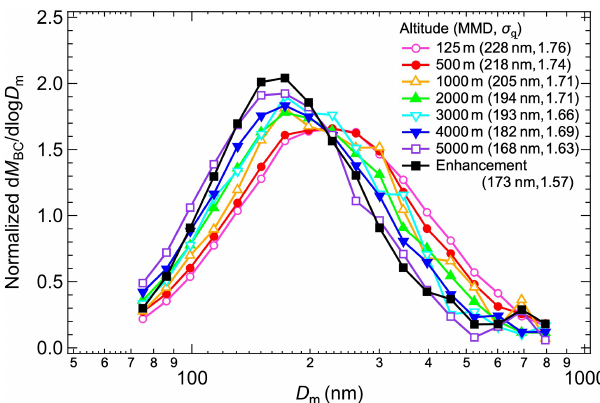
Figure 9. Averaged mass size distribution of BC in each altitude range. Values normalized by the total mass concentrations of BC ((d M BC / dlog D m ) /M BC ) are shown. The average size distribu- tion for the enhanced M BC data is shown with black squares. The numbers shown in parentheses are the mass median diam- eter (MMD) and the geometric standard deviation ( σ g ) for the lognormal-fitted size